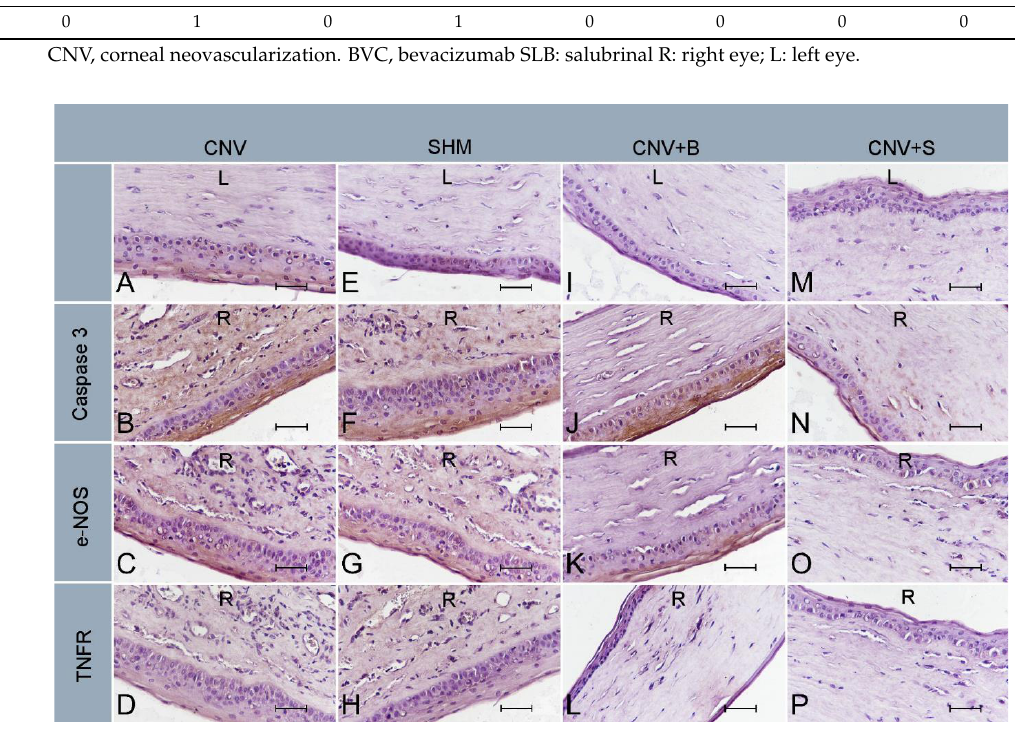
Figure 3. Immunohistochemical stainings. No immunoreactivity was observed in CNV-L ( A ), SHM-L ( E ), CNV + B-L ( I ), or CNV + S-L ( M ) groups with caspase-3, e-NOS, and TNFR. Increased caspase-3 immunoreactivity in CNV-R ( B ) and SHM-R ( F ) groups and negative capase-3 immunoreactivity in CNV + B-R ( J ) and CNV + S-R ( N ) groups. A slight increase in e-NOS immunoreactivity in CNV-R ( C ) and SHM-R ( G ) groups and negative e-NOS immunoreactivity in CNV + B-R ( K ) and CNV + S-R ( O ) groups. Negative immunoreactivity with TNFR in CNV-R ( D ), SHM-r ( H ), CNV + B-R ( L ), and CNV + S-R ( P ) groups. ×40, scale bar = 50 µm.